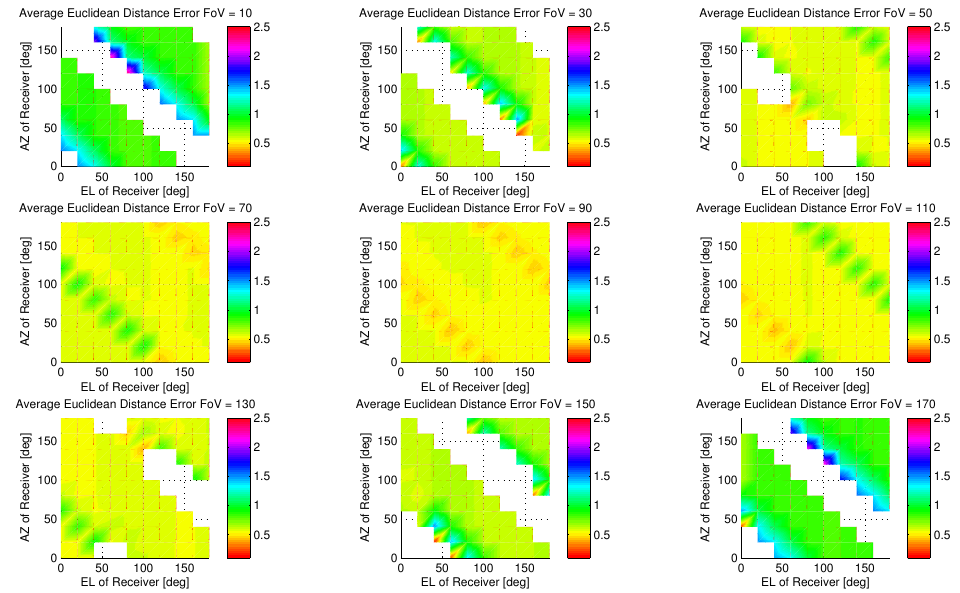
Figure 7. Coarse Performance for Varying Field of Views as a function of Receiver